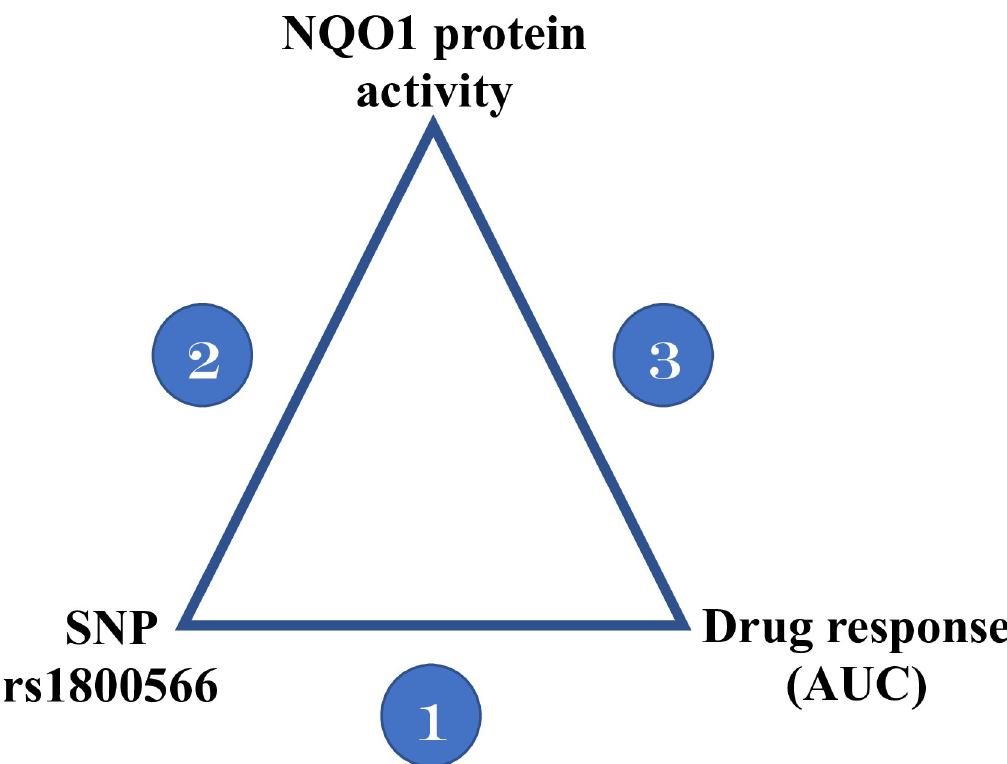
Fig 4. The three-stage protein QTL model used to identify the mechanism by which SNP rs1800566 influences drug response. Stage 1: the association between SNP rs1800566 and drug response measured as AUC; Stage 2: the association between SNP rs1800566 and NQO1 protein activity; and Stage 3: the association between NQO1 protein activity and drug